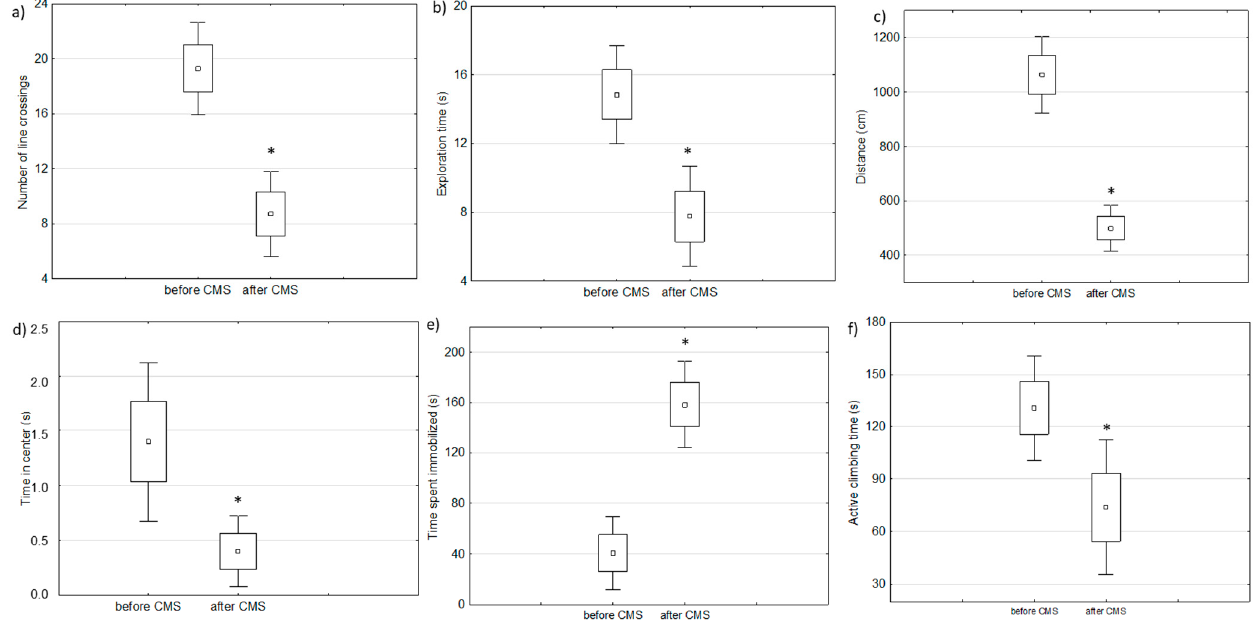
Table 1. Gene Ontology (GO) terms enriched from significantly downregulated genes between rats with manic-like behavior and control rats in the amygdala.